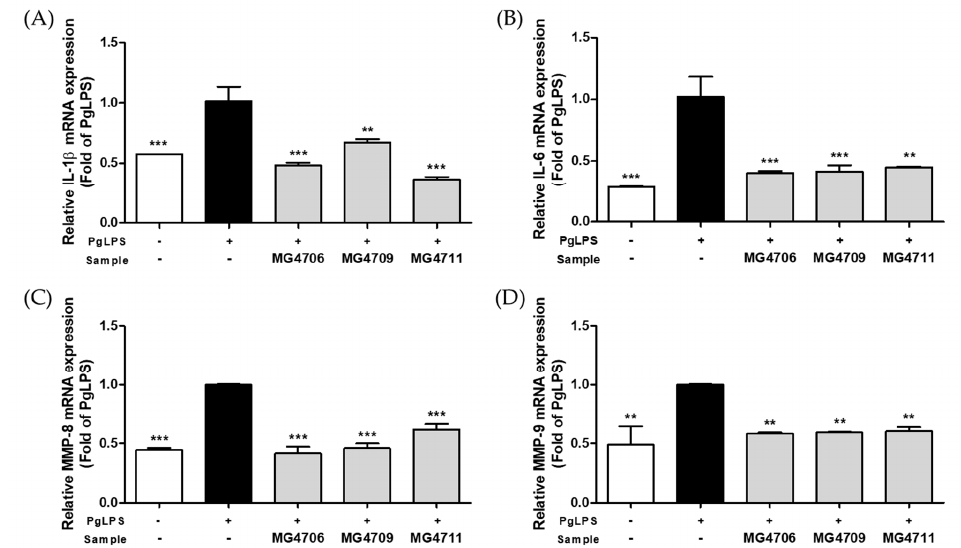
Figure 3. Effect of CFSP from LAB on mRNA expression of ( A ) interleukin ( IL ) -1 β ( B ) IL-6 ( C ) matrix metalloproteinase ( MMP ) -8 and ( D ) MMP-9 in PgLPS-stimulated human gingival fibroblasts-1 (HGF)-1 cells. Data are represented as mean ± SEM ( n = 3). Significance was analyzed by Dunnett’s test. ** p < 0.01, *** p < 0.001 versus only treated-PgLPS group.